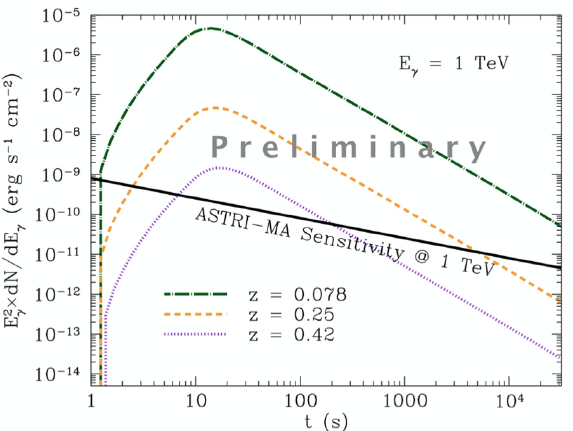
Figure 31. Light-curve of GRB190114C at 1TeV (dotted purple curve) compared to the sensitivity of the ASTRI Mini-Array. The yellow dashed and green dot-dashed curves show how GRB190114C rescaled at redshift z = 0.25 and z = 0.078, respectively, would appear. From